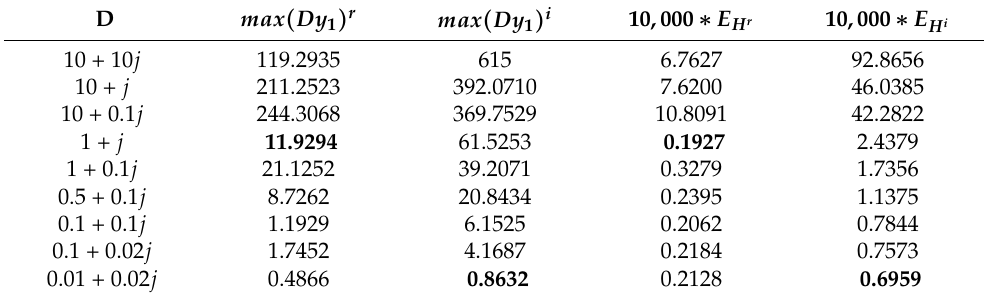
Figure 6. The CMPDFS process without noise when D = 0.1 + 0.1 j . Moreover, from a large number of experiments, when the amplitude of the chaotic signal Dy 1 is approximately equal to that of the message signal H , the sum of the error square is minimized. This conclusion can also be drawn from the bold fonts in Table 2, where max ( Dy 1 ) r and max ( Dy 1 ) i are the maximum amplitudes of the real part and imag- inary part of the chaotic signal, respectively. The terms 10, 000 ∗ E H r and 10, 000 ∗ E represent the sum of error square of recovered signal as the simulation program runs 10,000 times. According to (11), the maximum amplitude of H r is 10, while that of H i is 1. When D = 1 + j , max ( Dy 1 ) r is 11.9294, which is the closest to H r , and the sum of error is the minimum 0.1927 in the fourth column; when D = 0.01 + 0.02 j , max ( Dy 1 ) i is 0.8632, which is the closest to H i , and the sum of error is the minimum 0.6959 in the fifth column. Table 2. The sum of error square with different D